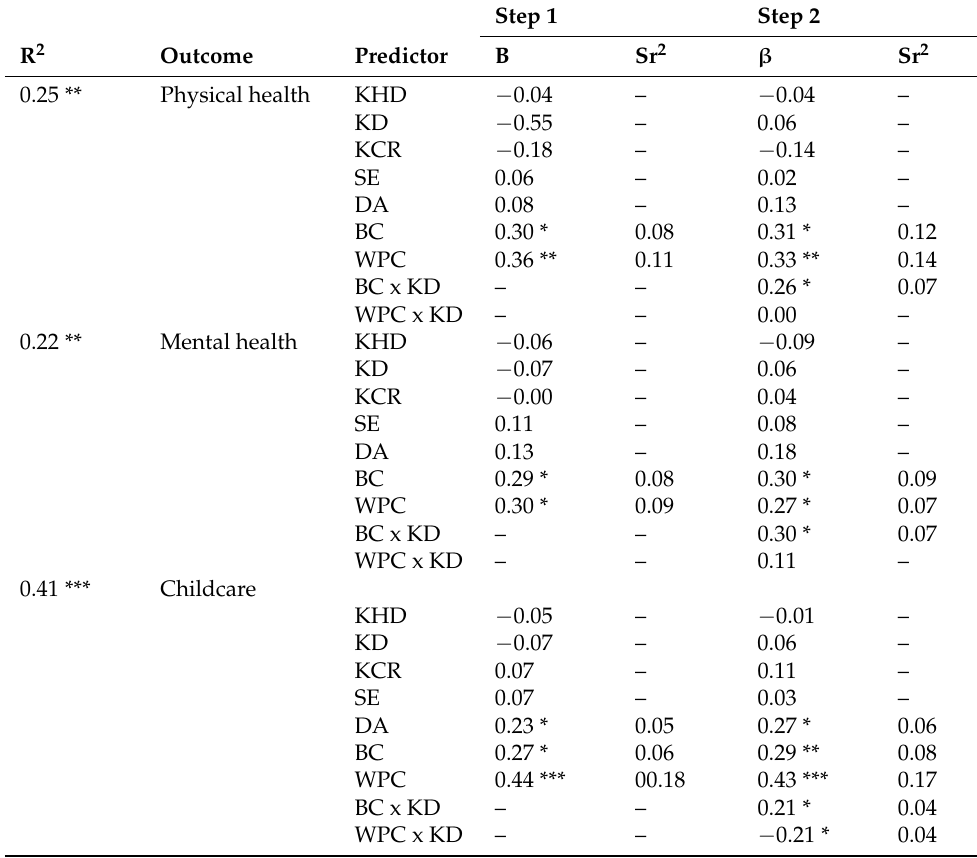
Table 3. Hierarchical multiple regression models of likelihood of granting flexibility for